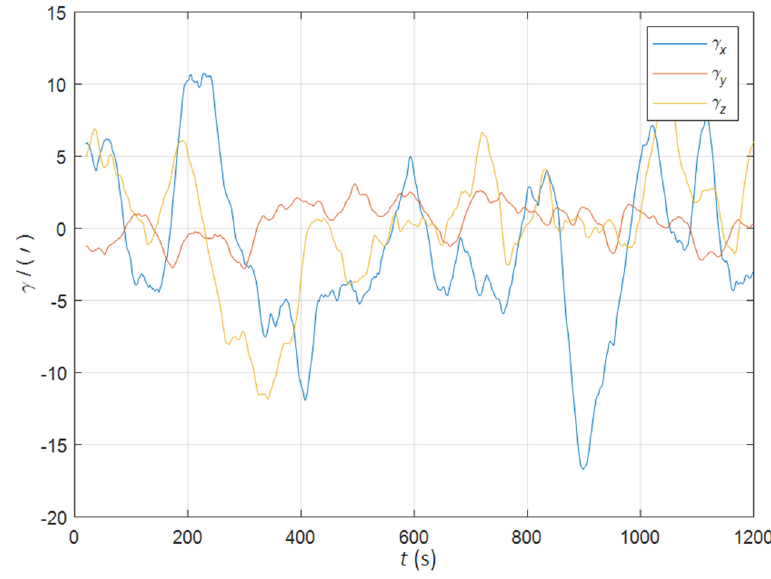
Figure 2. The curves of the dynamic deflection angle in the quasi-static swing base.